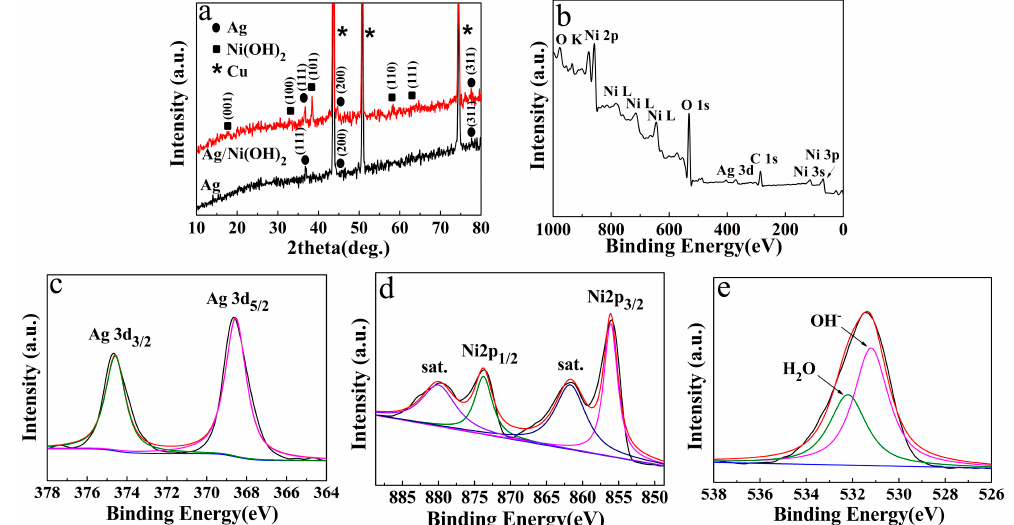
Figure 3. XRD patterns ( a ) Ag and Ag / Ni(OH) 2 . XPS of the Ag / Ni(OH) 2 : survey scan ( b ), Ag 3d ( c ), Ni 2p ( d ) and O 1s ( e ) spectra.